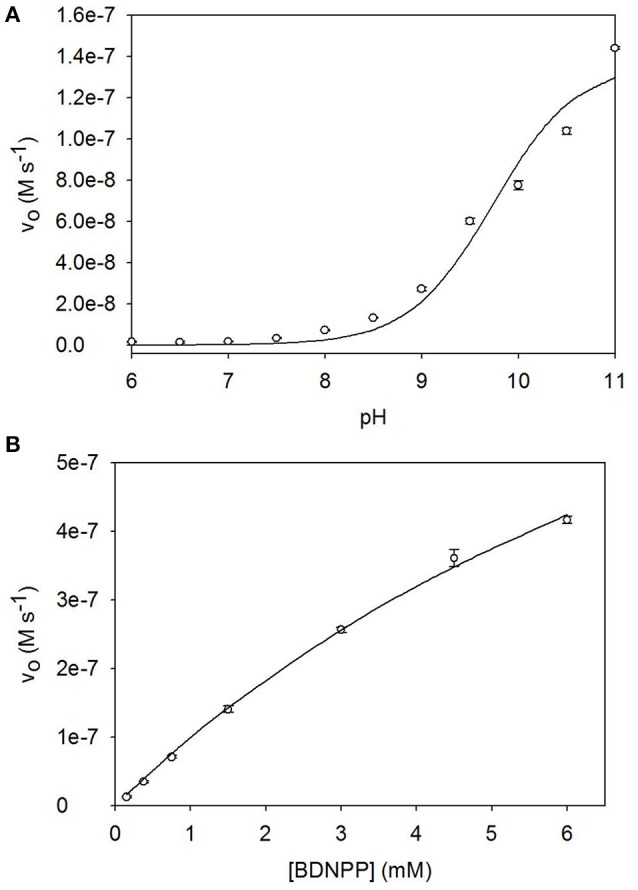
(A) pH dependence profile, and (B) Michaelis-Menten plot for the hydrolysis of BDNPP catalyzed by [Ni2(L1)(μ-OAc)(H2O)2](ClO4)2·H2O.